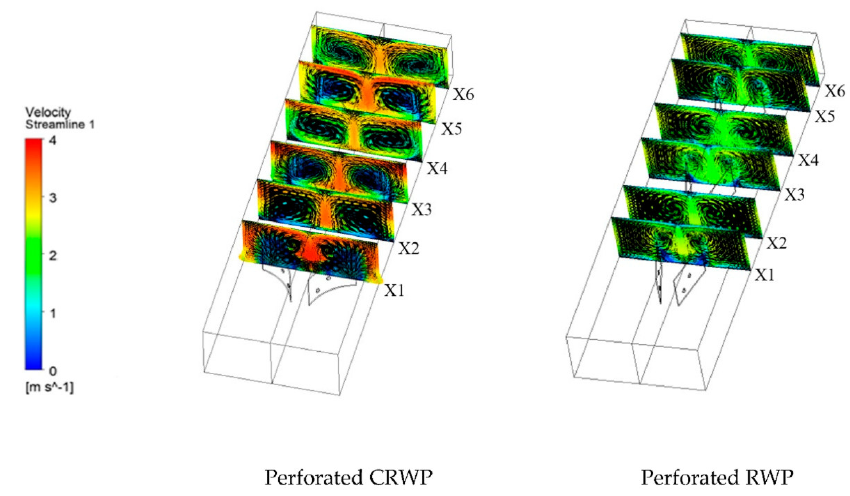
Figure 7. Tangential velocity vector on the use of perforated RWP and CRWP VGs.